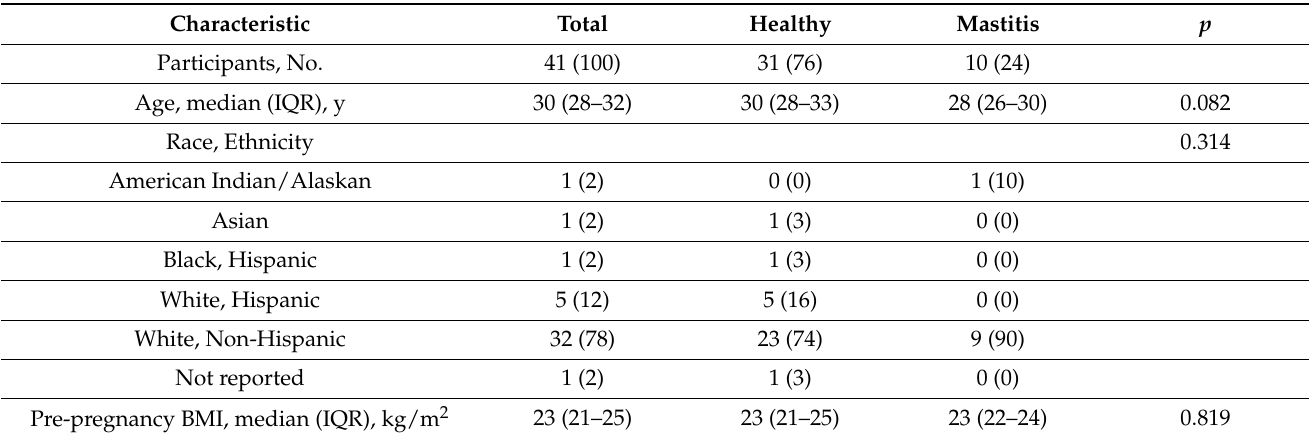
Table 1. Selected participant